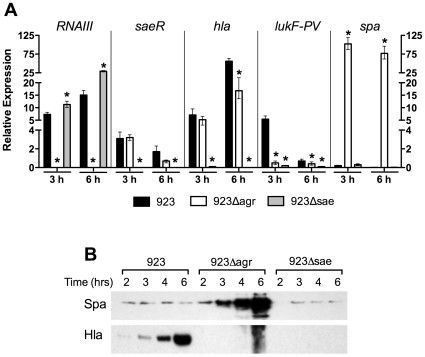
Deletion of agr or saeRS altered expression of global regulators (RNAIII and saeR) and downstream virulence factors (hla, lukF-PV, and spa).(A) Expression of global regulators and downstream virulence factors in strains 923, 923Δagr, and 923Δsae by qRT-PCR at 3 and 6 hrs of growth. Expression of each gene is quantified relative to expression in strain 923 at 2 hrs (corrected for housekeeping gene). Data are presented as mean ± SEM. * indicates p<0.05 compared with strain 923 at same time point. (B) Abundance of protein A (Spa) and α-hemolysin (Hla) in culture supernatants of strains 923, 923Δagr, and 923Δsae at 2, 3, 4, and 6 hrs of growth, as assessed by Western blot.